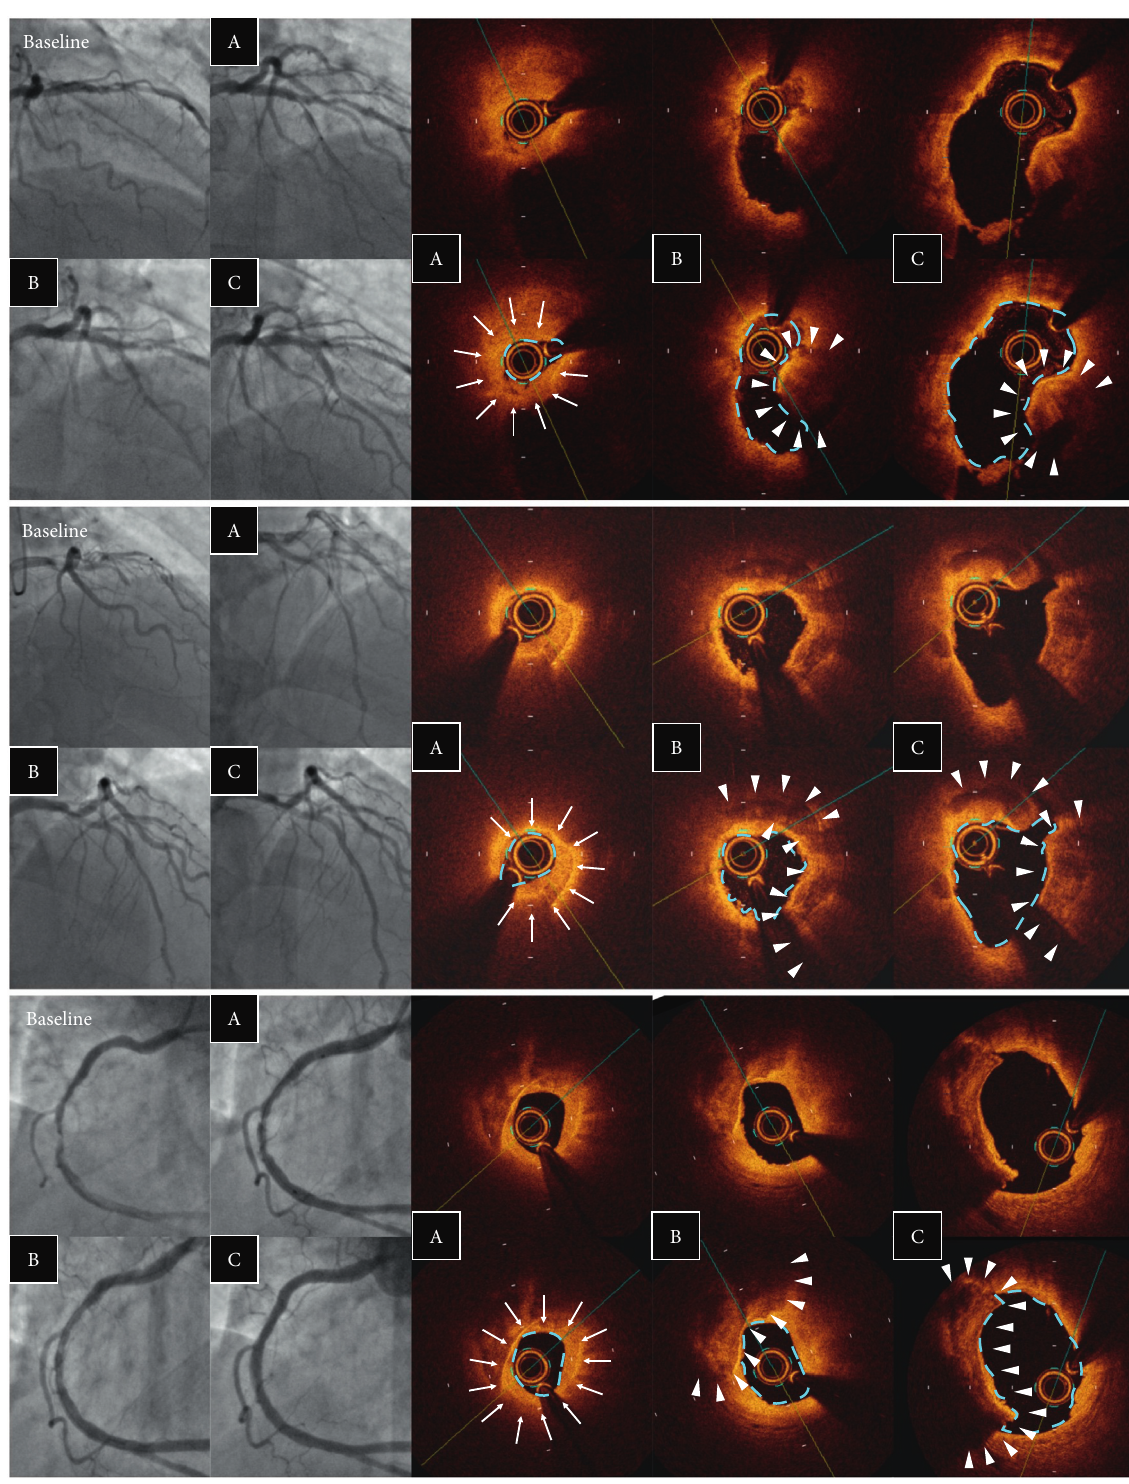
Figure 6: Examples of calcium nodules. Angiographic and OCTimages after (A) MT, (B) ELCA, and (C) ballooning. Laser vaporization of the thrombus (arrow) clarified the identification of nodular protruding calcium (arrow head). ELCA, excimer laser coronary angioplasty; MT, manual aspiration thrombectomy; and OCT, optical coherence